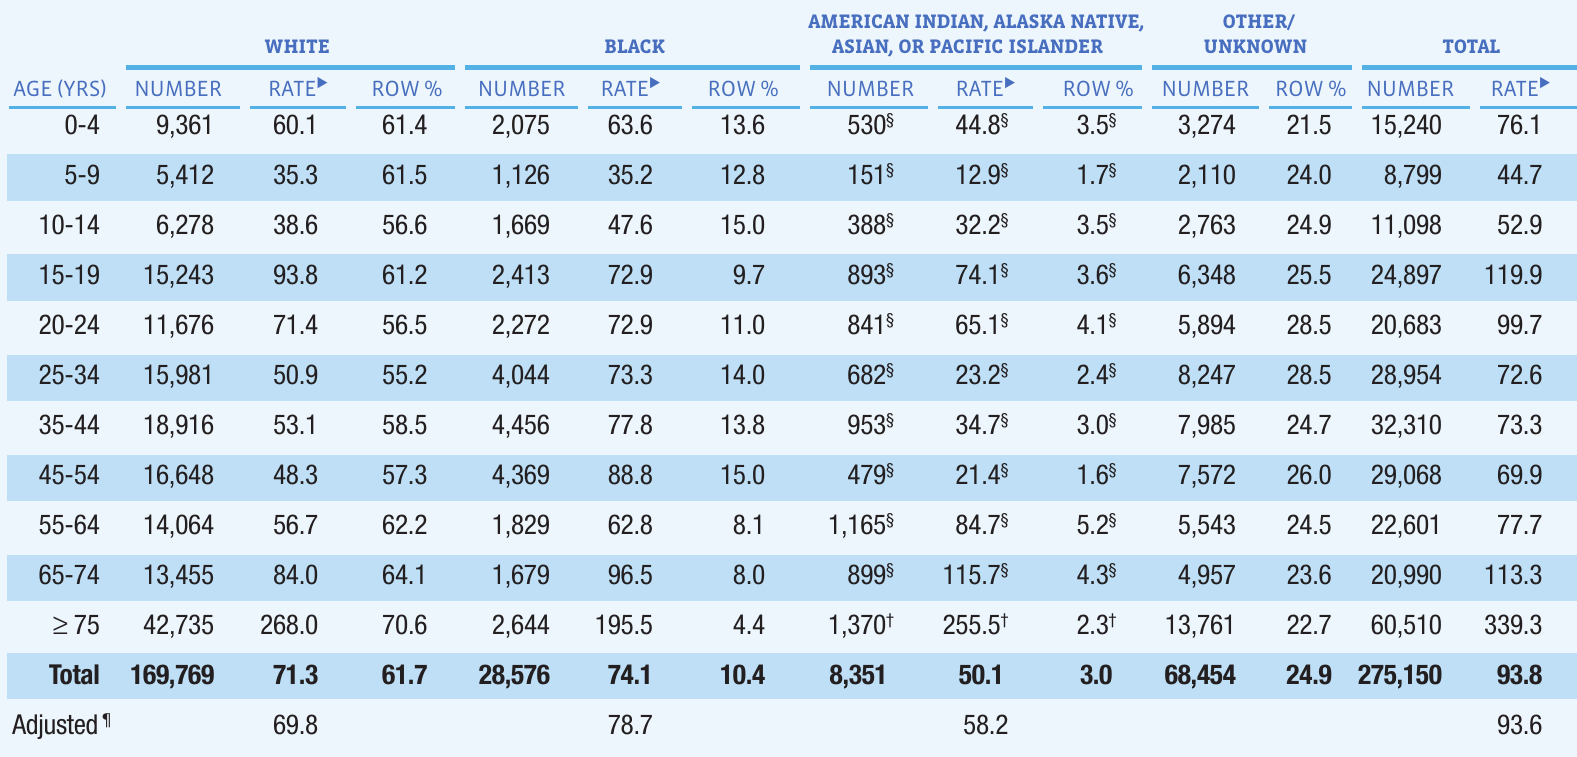
TABLE 10: Estimated Average Annual Numbers, Rates, and Percentages of Traumatic Brain Injury- Related Hospitalizations, by Age Group and Race, United States, 2002–2006